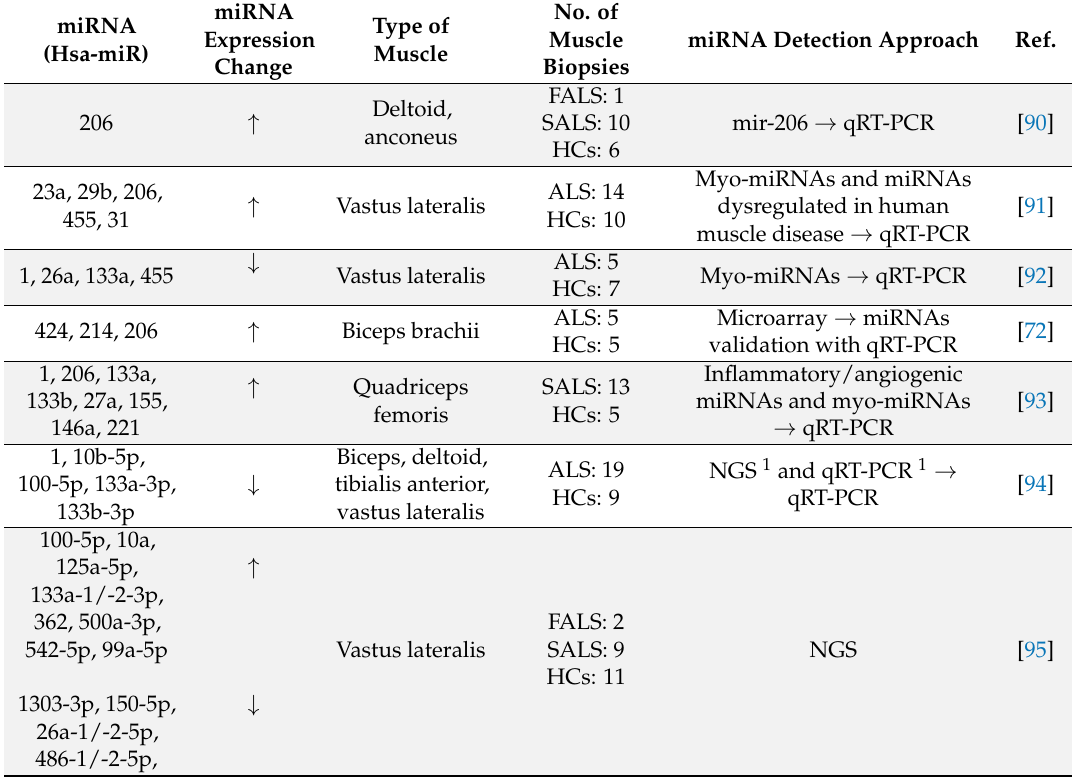
Table 4. Deregulated miRNAs in skeletal muscle biopsies of amyotrophic lateral sclerosis (ALS) patients compared to healthy